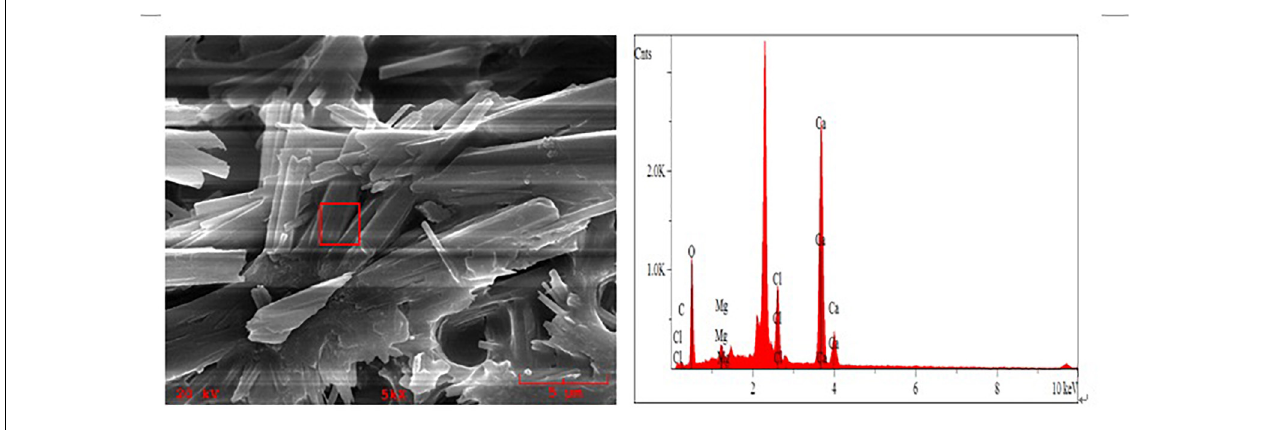
FIGURE 2 | SEM images and energy spectrum of the